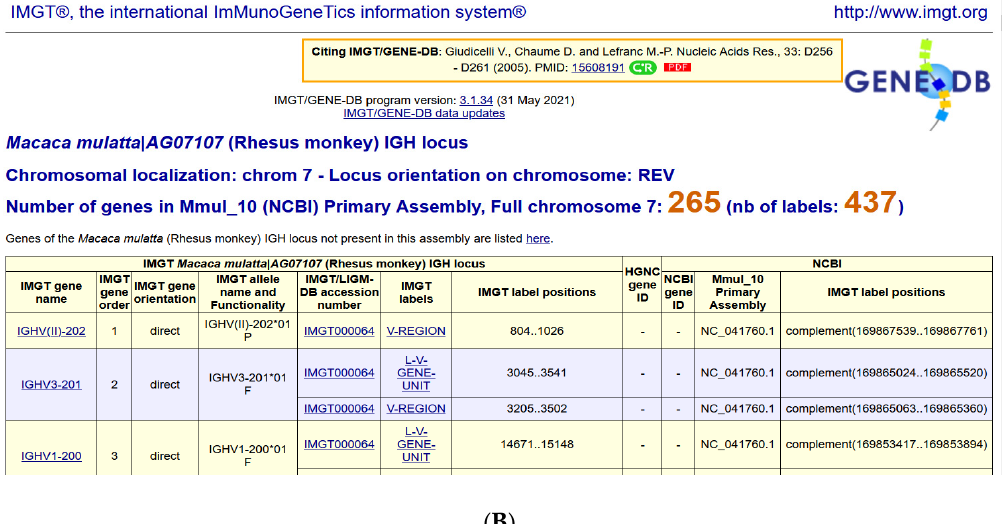
Figure 4. IMGT/GENE-DB Localization in genome assemblies. ( A ) Query for Macaca mulatta|AG07107 (Species, AG07107 isolate) and IGH (Locus) showing the availability of IMGT/GENE-DB biocurated genes for the assembly ‘Mmul_10, NCBI’. ( B ) Top of the results page for the query. IMGT alleles of a given gene are defined by the number which follows the asterisk (i.e., *01) (With permission from M–P. Lefranc and G. Lefranc, LIGM, Founders and Authors of IMGT ® , the international ImMunoGeneTics information system ® , http://www.imgt.org) (accessed on 20 February 2022).